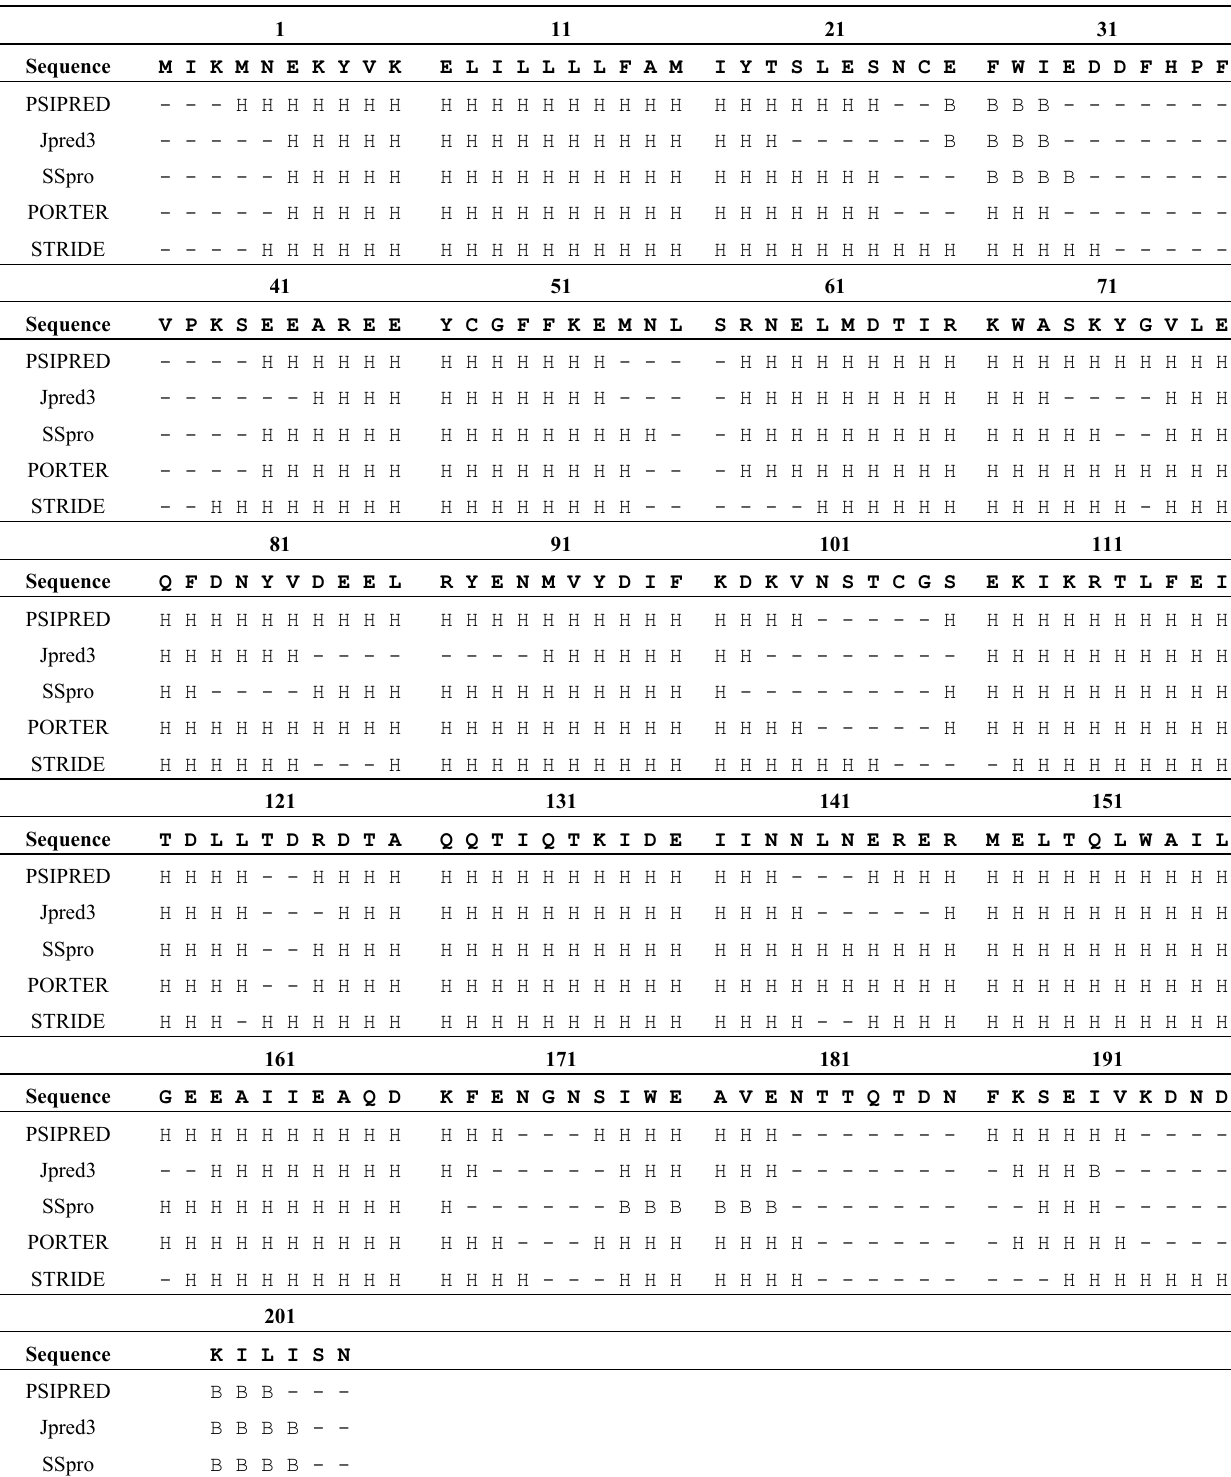
Table 1. Secondary structure prediction by PSIPRED [5], Jpred3 [6], SSpro 4.0 [7] and PORTER [8]. Secondary structure calculation of average MD structure performed by STRIDE